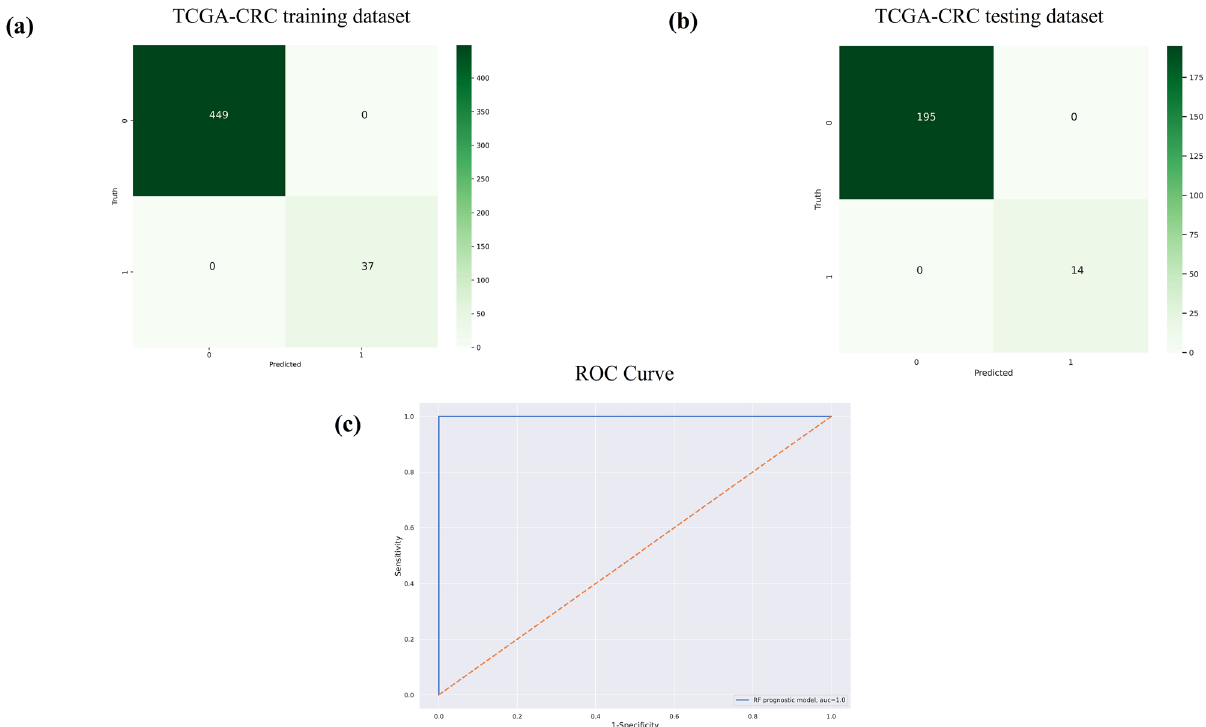
Figure 4. Random Forest based prognostic model performance analysis. ( a ) Confusion matrix of the training dataset between the truth and predicted values with 486 samples of TCGA-CRC dataset, ( b ) confusion matrix of the testing dataset between the truth and predicted values with 209 samples of TCGA-CRC dataset, and ( c ) ROC curve for RF based prognostic model with 33 features identified through boruta feature selection algorithm. 0 denotes tumor class while 1 denotes normal class sample